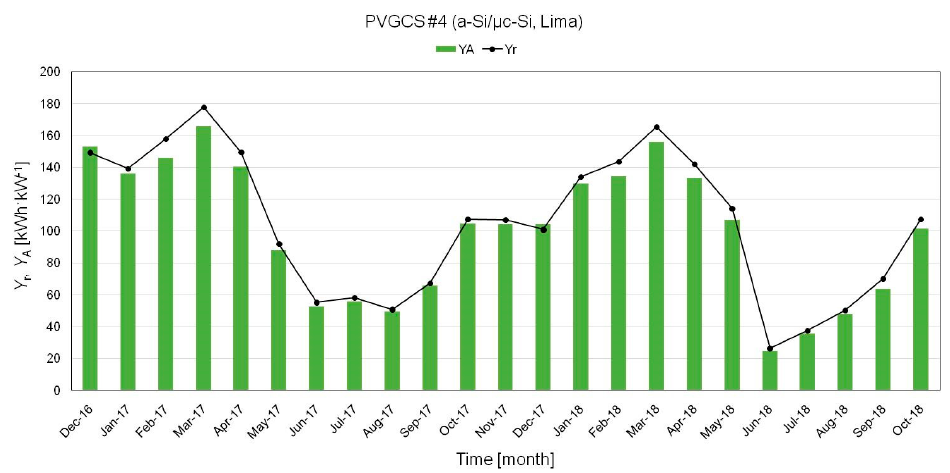
Figure 5. Values of Y r and Y A for PVGCS #4 over the period under scrutiny. Both the PV subfield and PVRD were cleaned on a weekly basis.